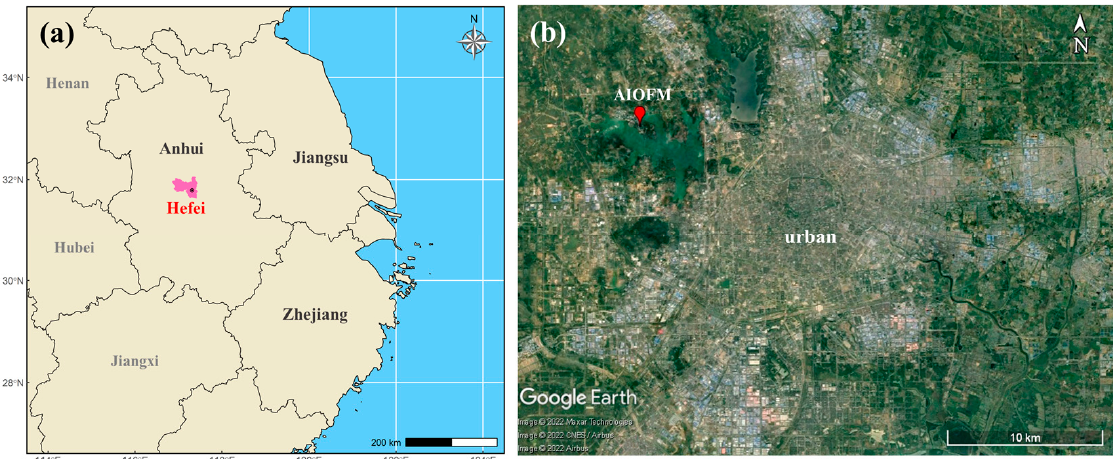
Figure 1. Location of Hefei city in the Yangtze River Delta of China ( a ) and a sampling site at the AIOFM ( b ).